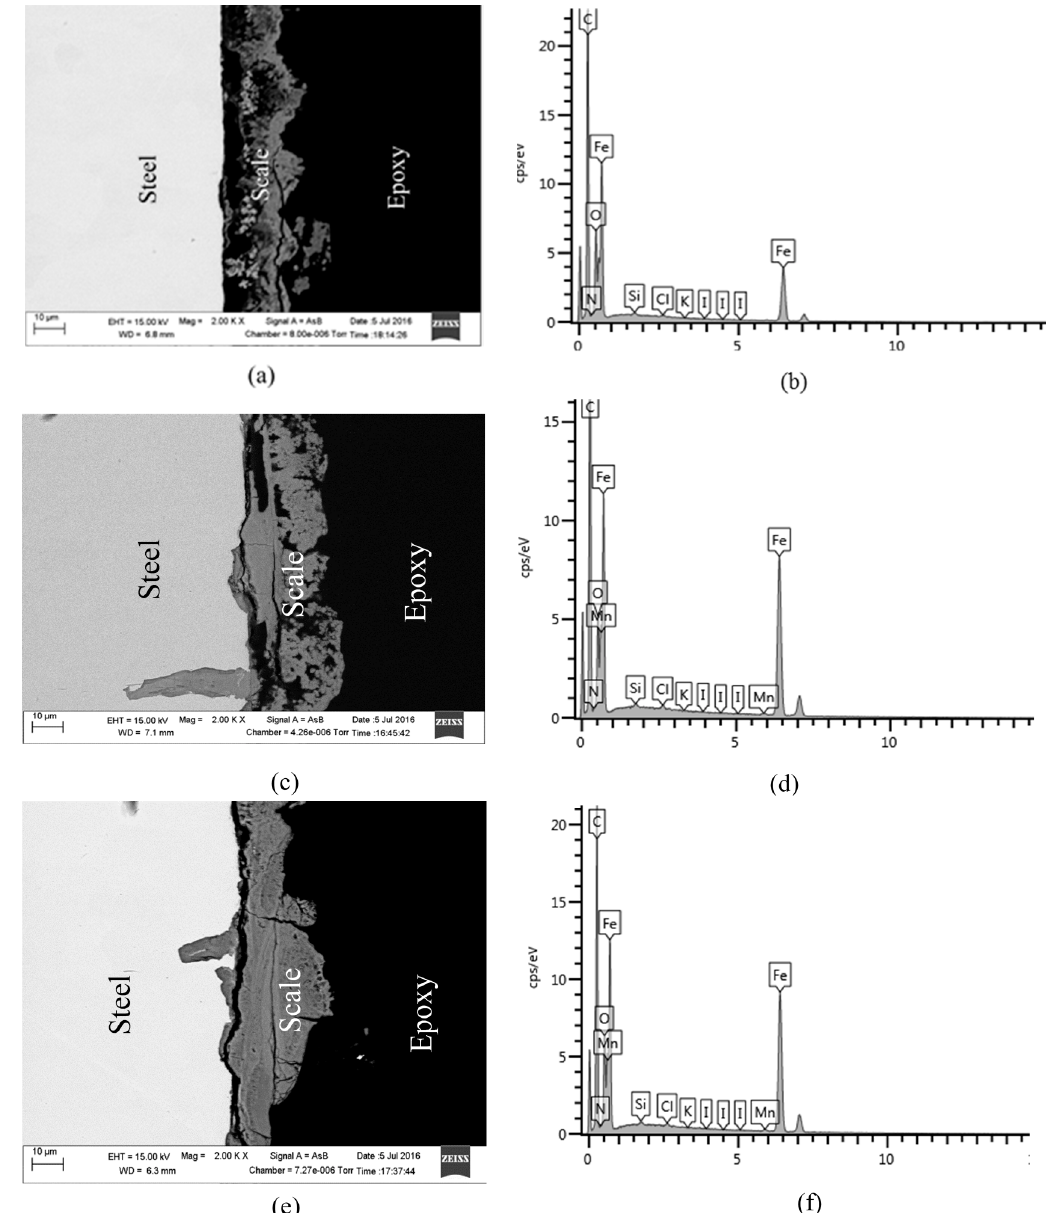
Figure 9. SEM cross-sectional images and EDS spectra after corrosion tests: ( a , b ) un-inhibited ( c , d ) nitrites ( e , f ) nitrites + KI containing solutions.